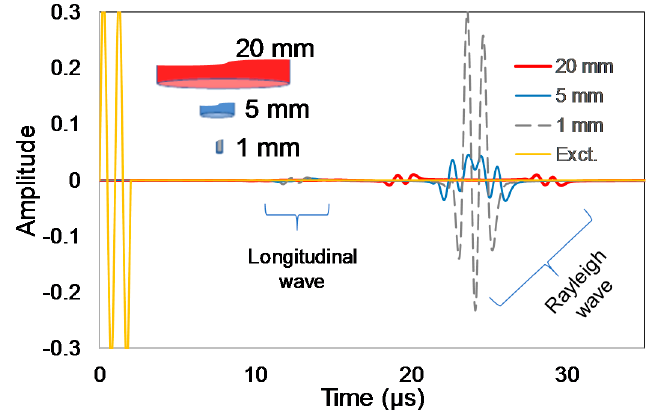
Figure 2. Waveforms received by different size sensors for the case of surface source and excitation frequency of 1 MHz. The excitation wave (yellow starting at time 0) was reduced to the graph axes for clarity (nominal amplitude of 1).